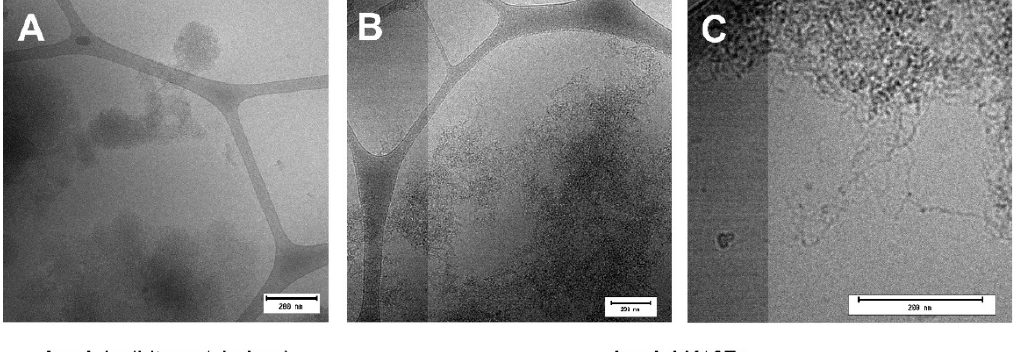
Figure 4. Cryo-TEM images of oxidized ( A ) wildtype ApoA-I, aggregated under agitation, and ( B,C ) K107 Δ ApoA-I. Both samples were aggregated in buffer with pH 6.0. For ( B,C ), the co-existence of larger, more compact aggregates ( B ), as well as more fibrillar structures ( C ) and single fibrils (Figure S7C,D) could be observed. The scale bar in each image is 200 nm (note the difference in magnification of the